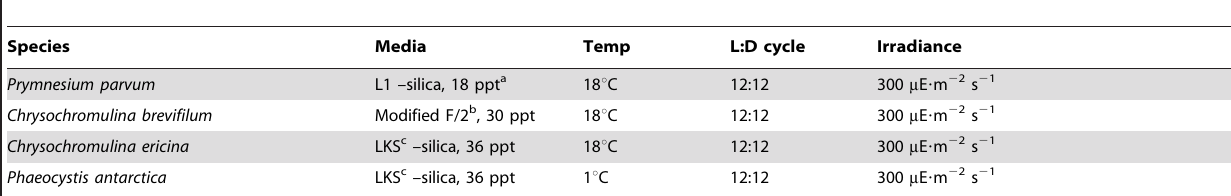
Table 1. Culture conditions for the four prymnesiophyte species in this study.